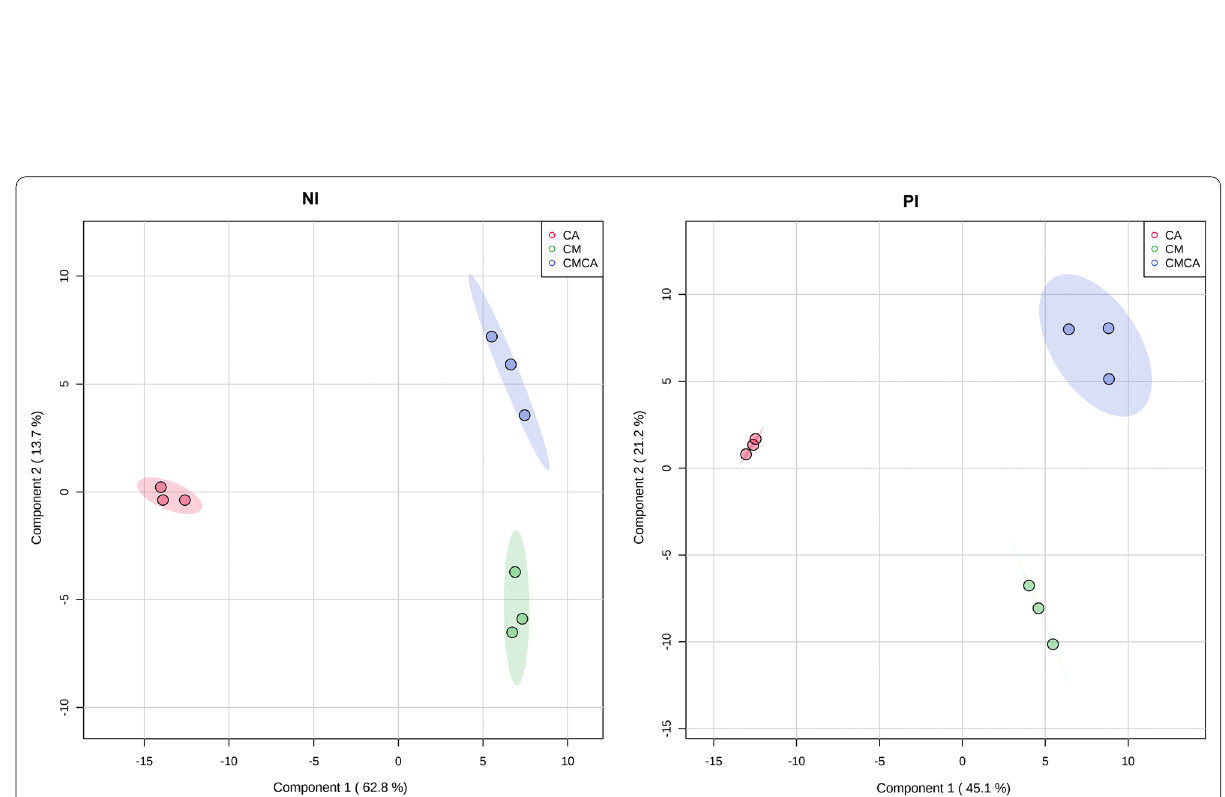
(NI) and ESI (PI) data obtained by UHPLC–HRMS (regional display of 95% confidence − +